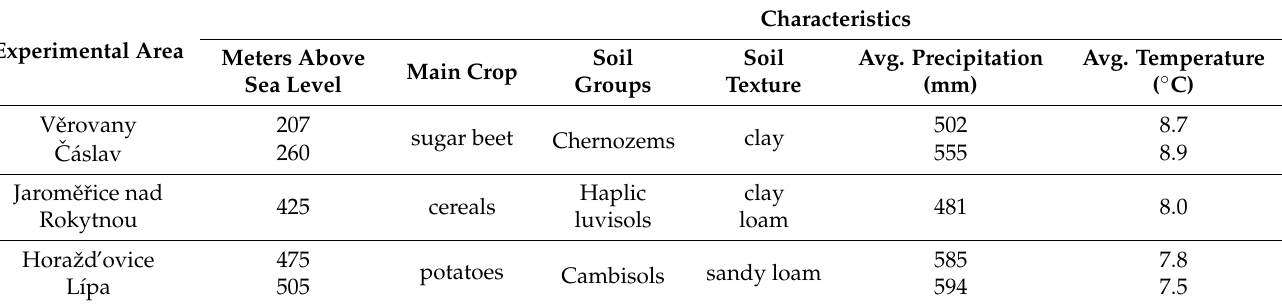
Characteristics